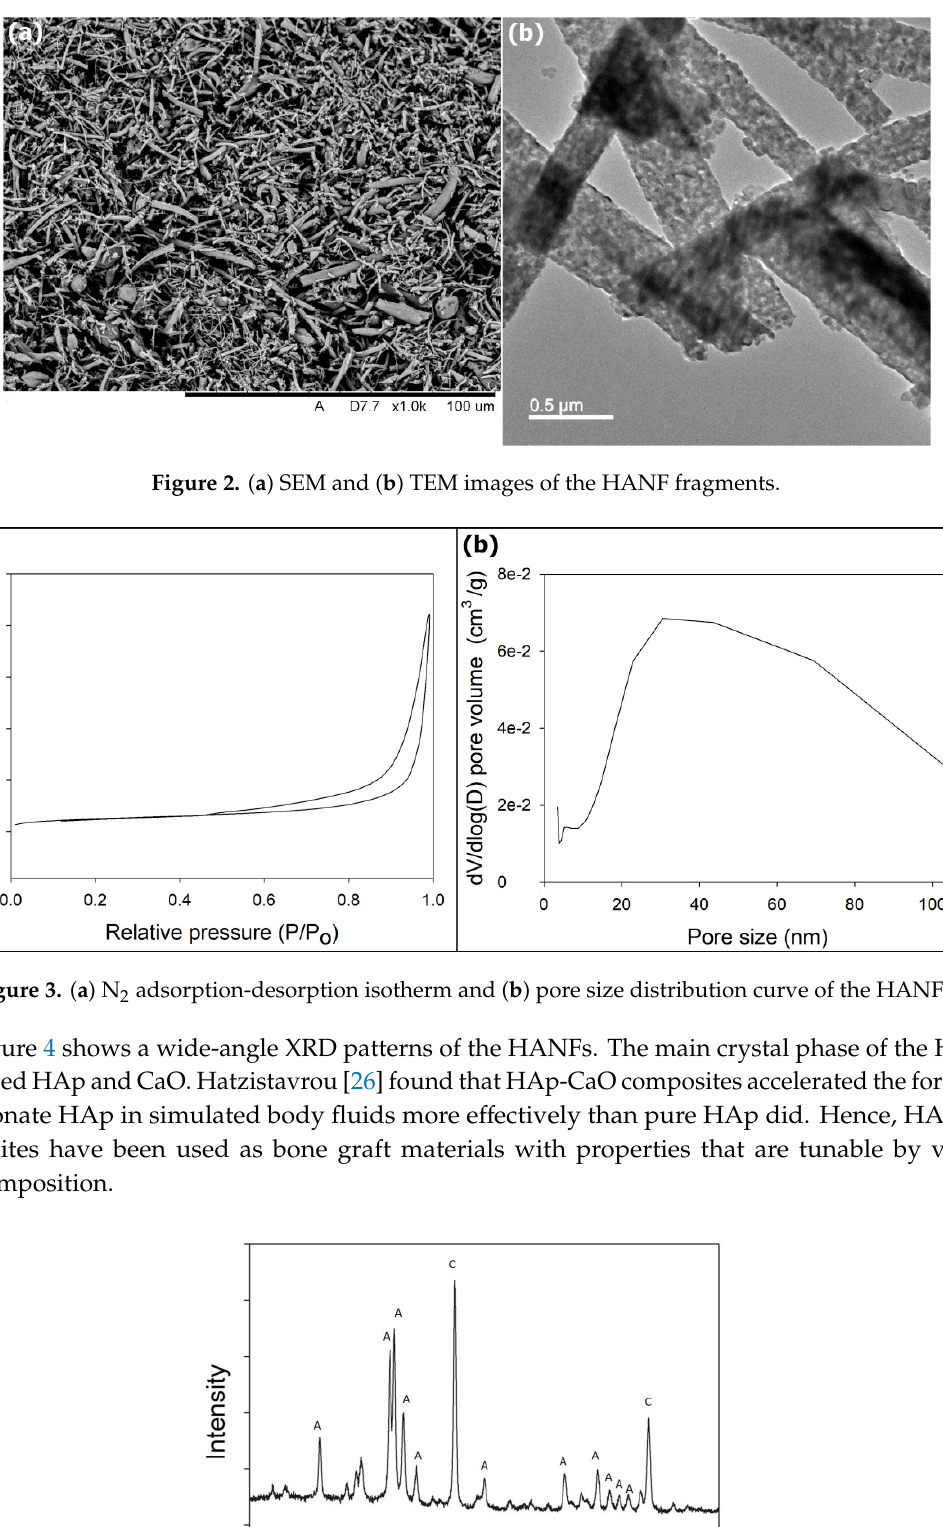
Figure 1. SEM micrograph of the HANFs. ( a ) 1000×. ( b ) 4000×.